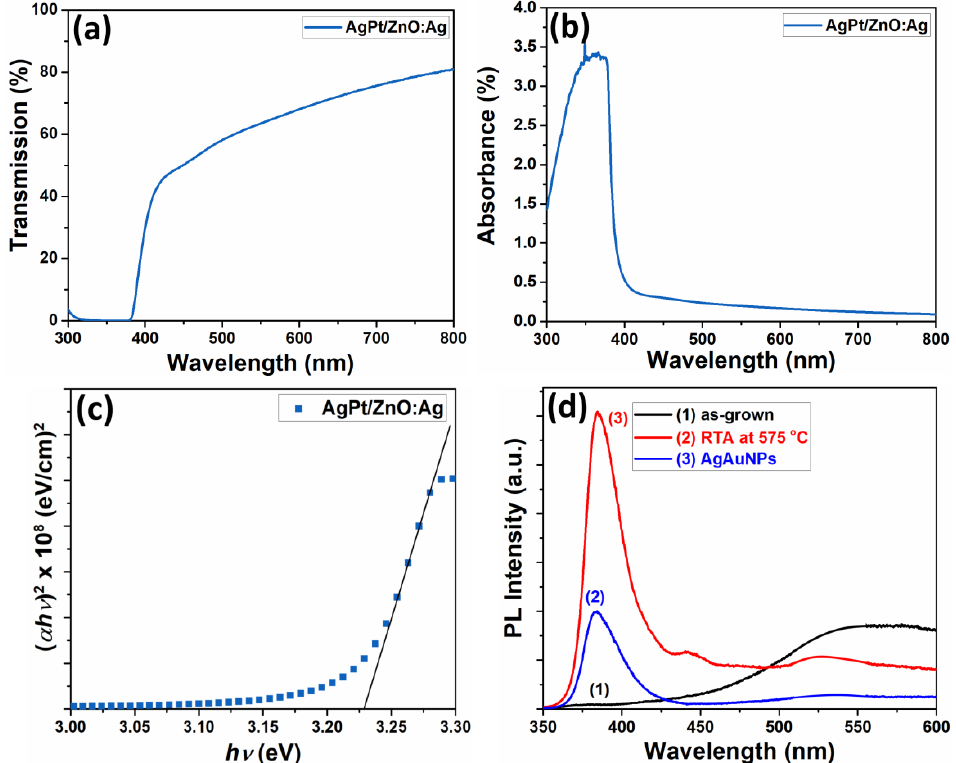
Figure 2. (a) Transmission spectra, (b) absorbance spectra and (c) plot of ( α h ν ) 2 vs. photon energy ( h ν ) of AgPt/ZnO:Ag films, (d) room temperature PL